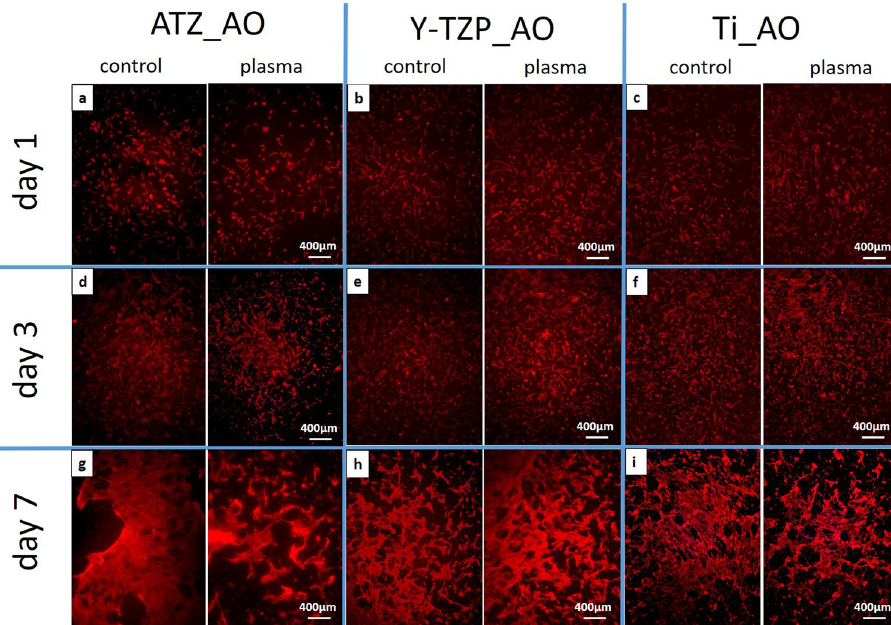
Figure 6. Immunofluorescence of phalloidin-labelled actin (red fluorescence) in osteoblasts cultivated for 1, 3 or 7 days on plasma-functionalized and control surfaces.